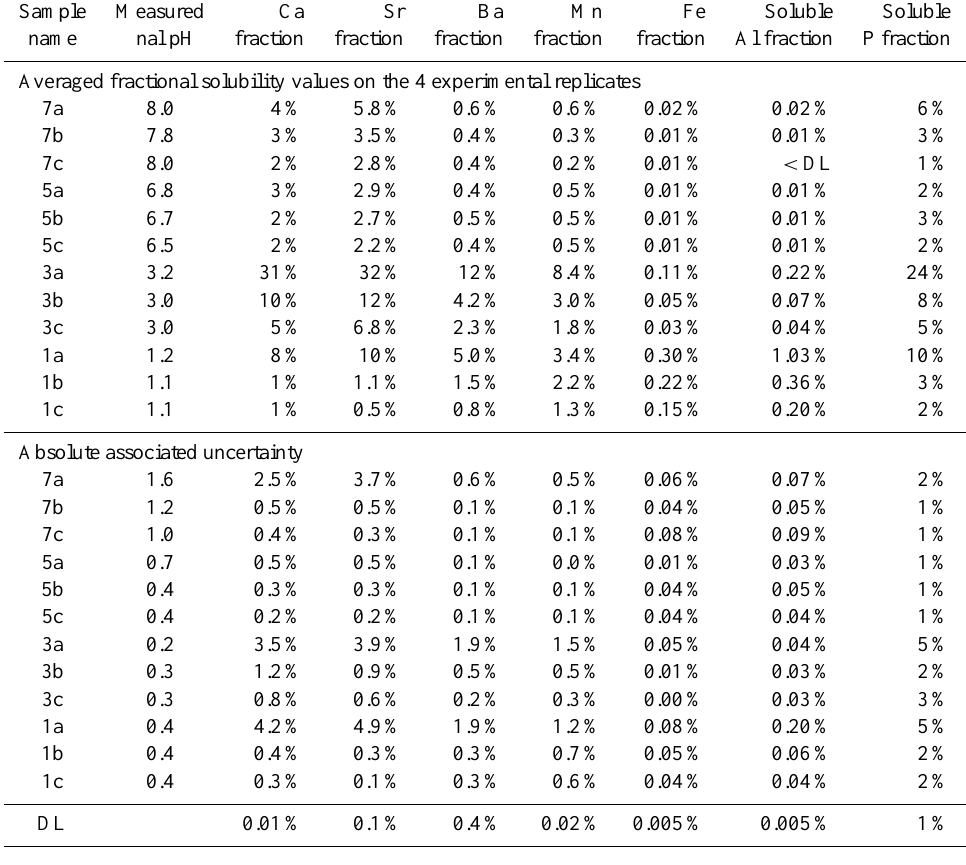
Table 2. Final pH and relative fractional solubility of each measured element for each leaching step. The associated uncertainty of the averaged measurements is calculated as three times the standard deviation of the four replicates divided by the square root of 4, the number of replicates. The uncertainty of cumulated dissolution should be calculated as the square root of the sum of the square of all previous dissolution steps.